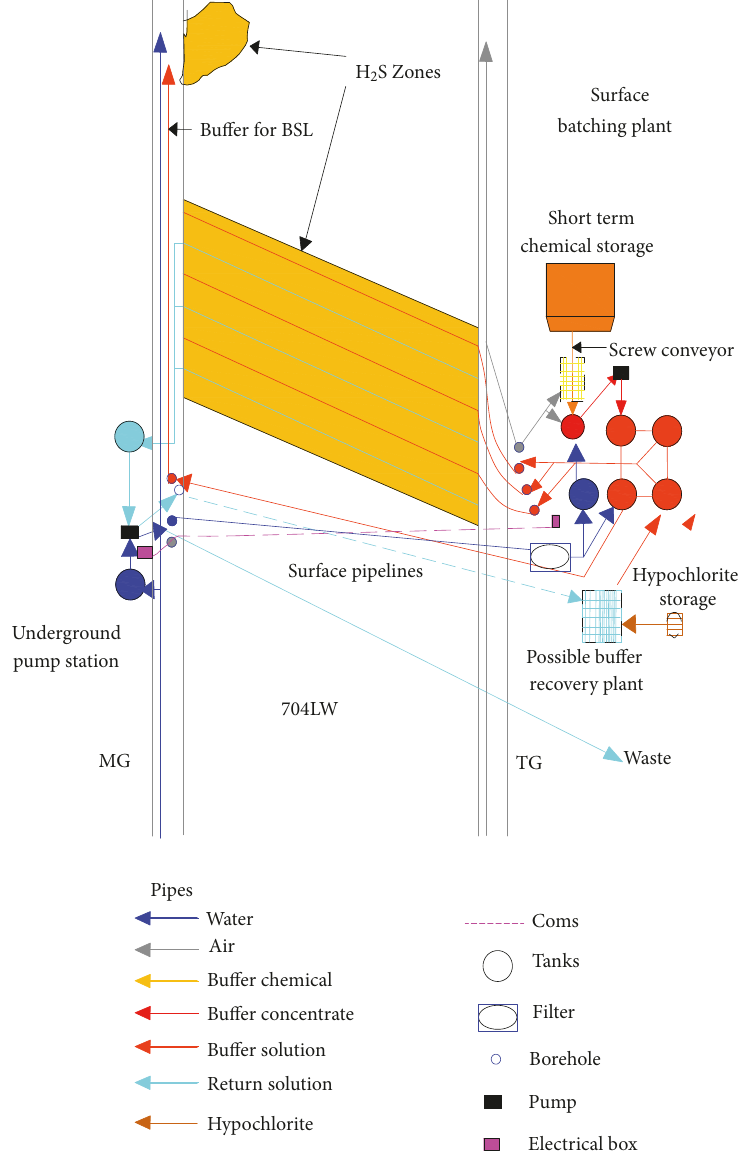
Figure 8: Longwall infusion